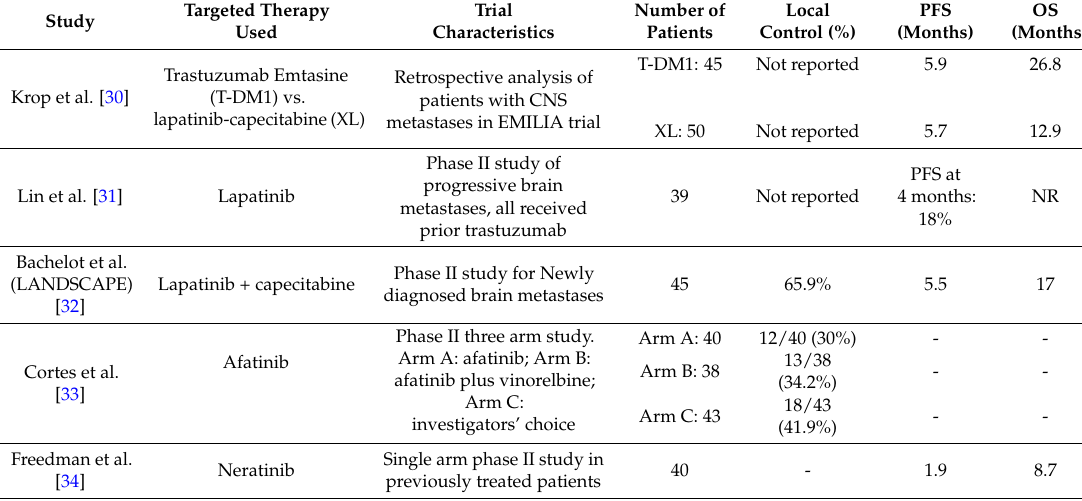
Table 1. Pivotal clinical trials using targeted agents in the management of brain metastases (BCBM).